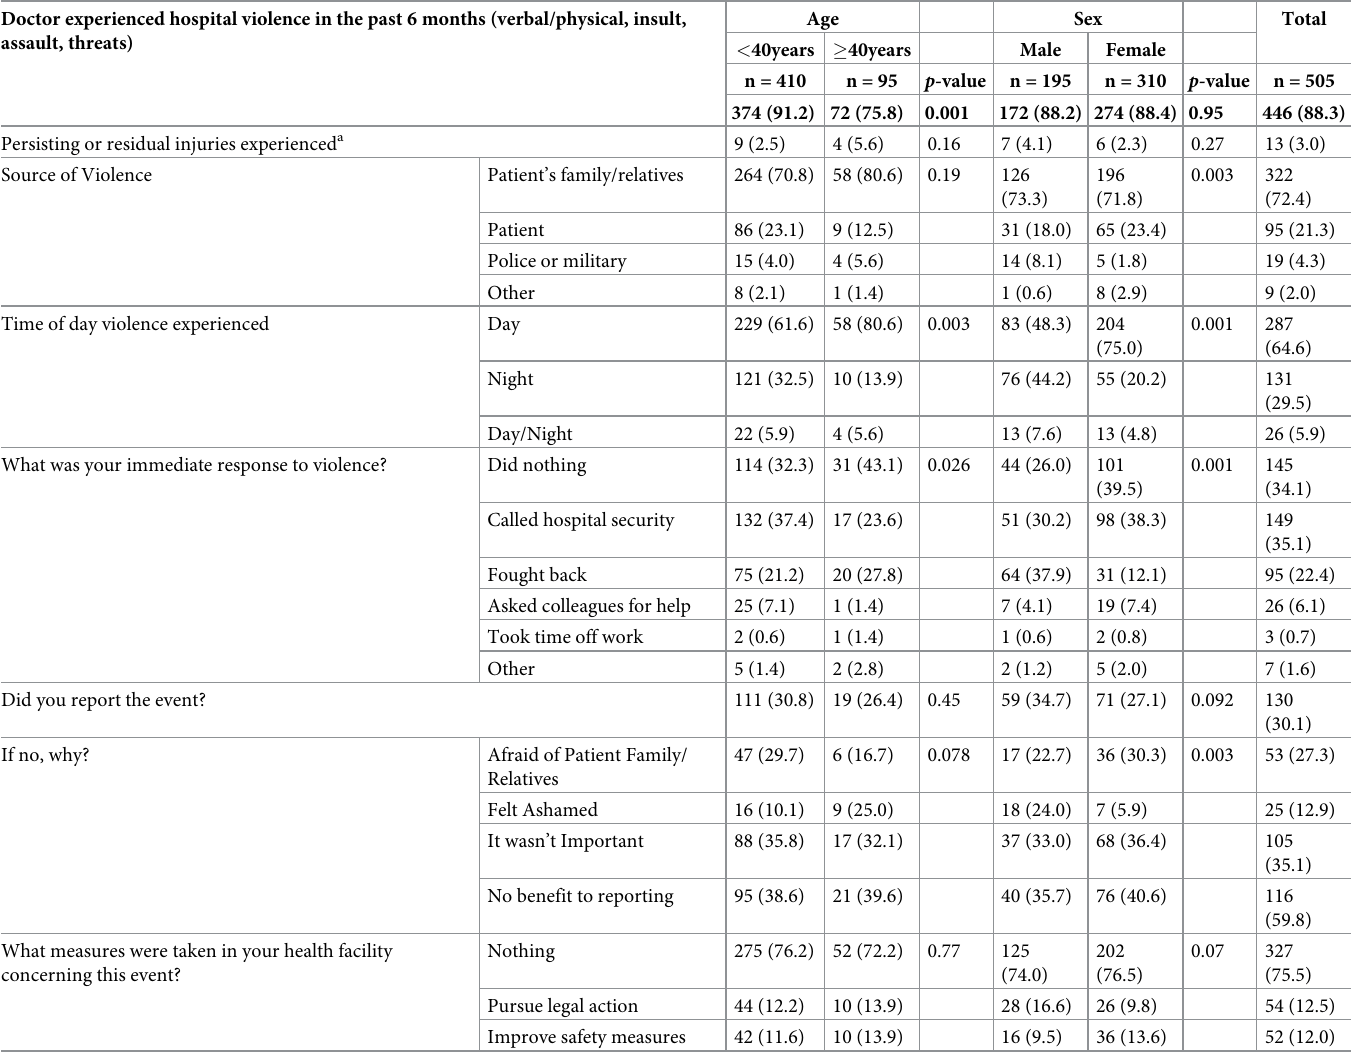
Table 2. Personal experience with violence, n